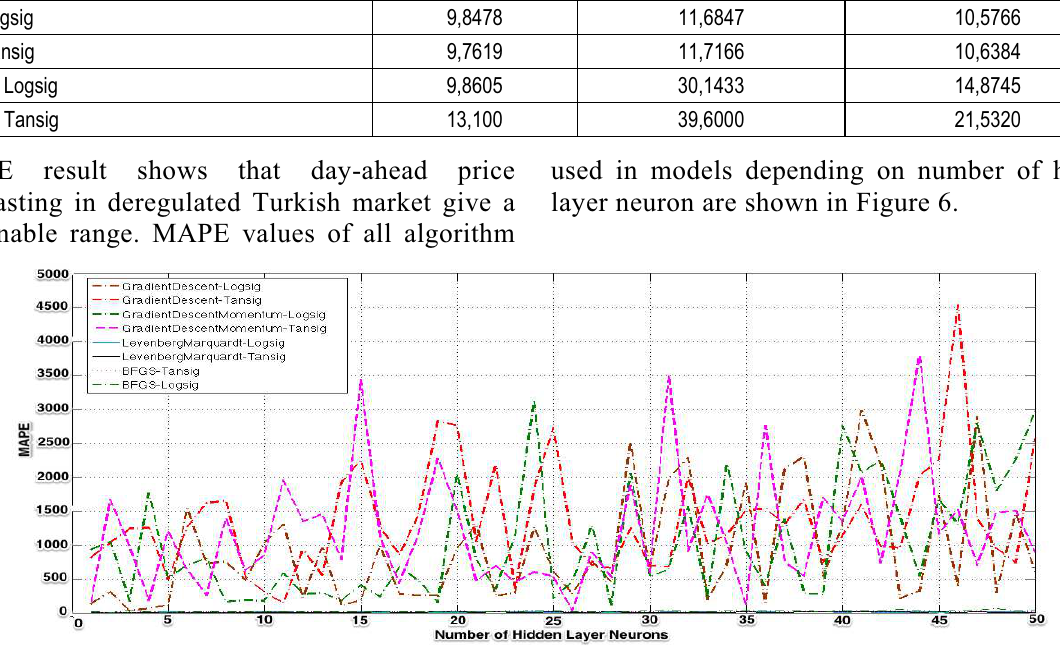
Fig. 8. Number of hidden layer neurons and transfer functions price forecast results algorithm Levenberg-Marquardt MAPE